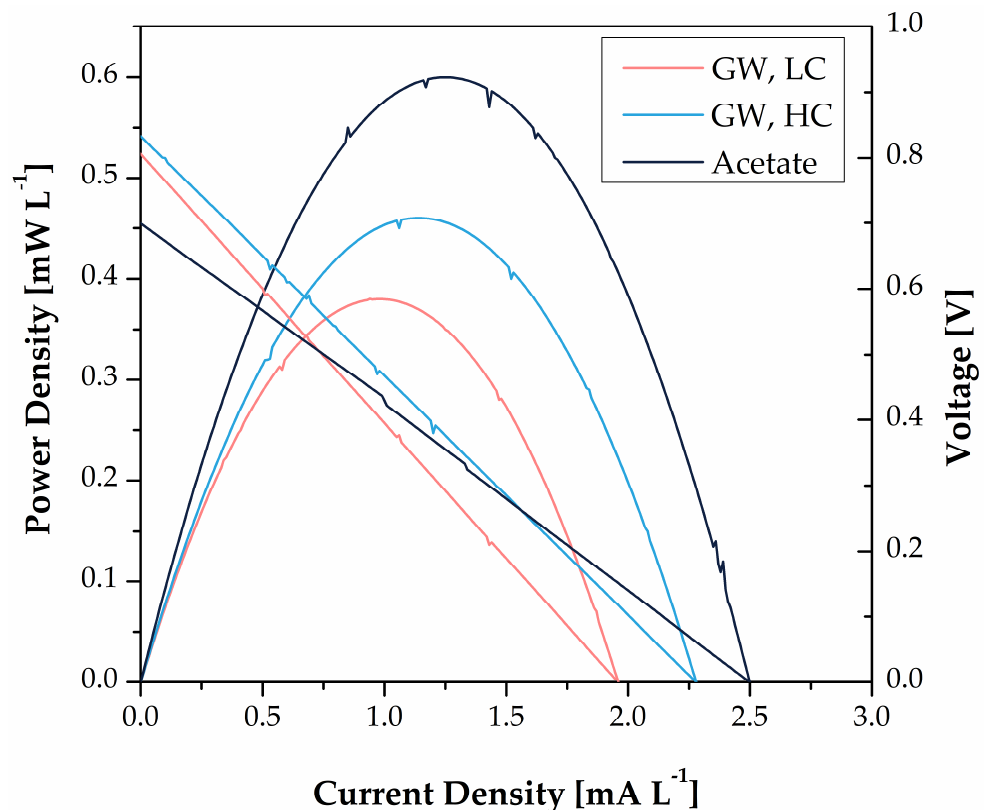
Figure 4. Polarization and power curves. GW, LC: greywater, low conductivity; GW, HC: greywater, high conductivity; acetate was used as anode feed in the control reactor.